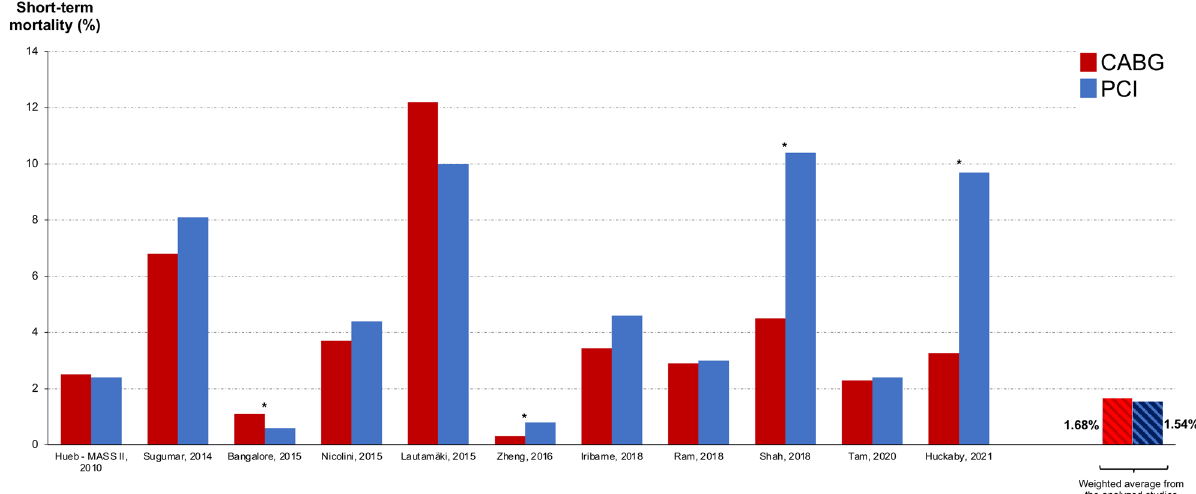
Figure 4. Periprocedural mortality found in the analyzed studies for PCI and CABG (excluding the non-risk- adjusted